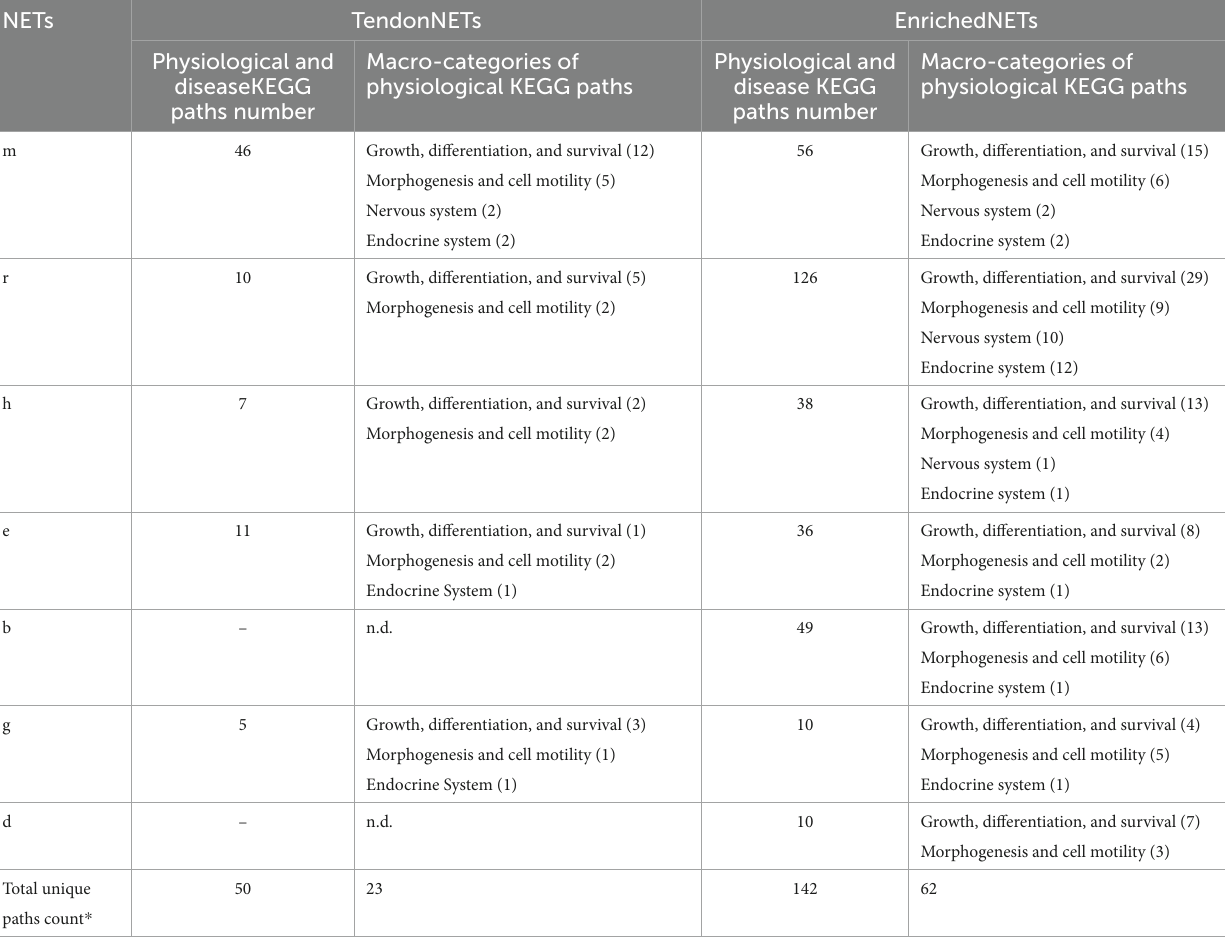
TABLE 4 KEGG paths grouped into BRITE macro-categories related to TendonNETs and Enriched TendonNETs.